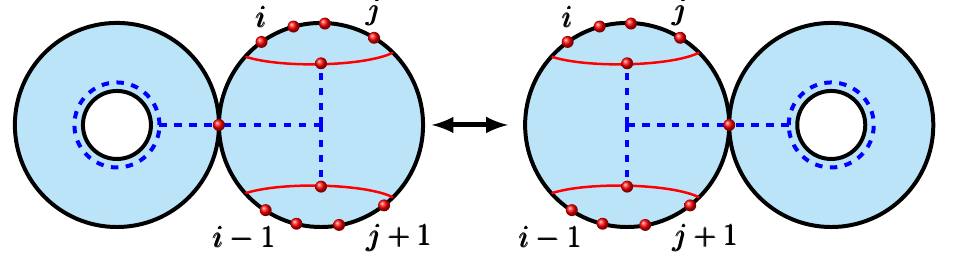
Figure 13 . A vertex of the Cyclohedron is represented by a nodal disk as in the left (cid:12)gure. We can pair it with the vertex represented by the nodal disk in the